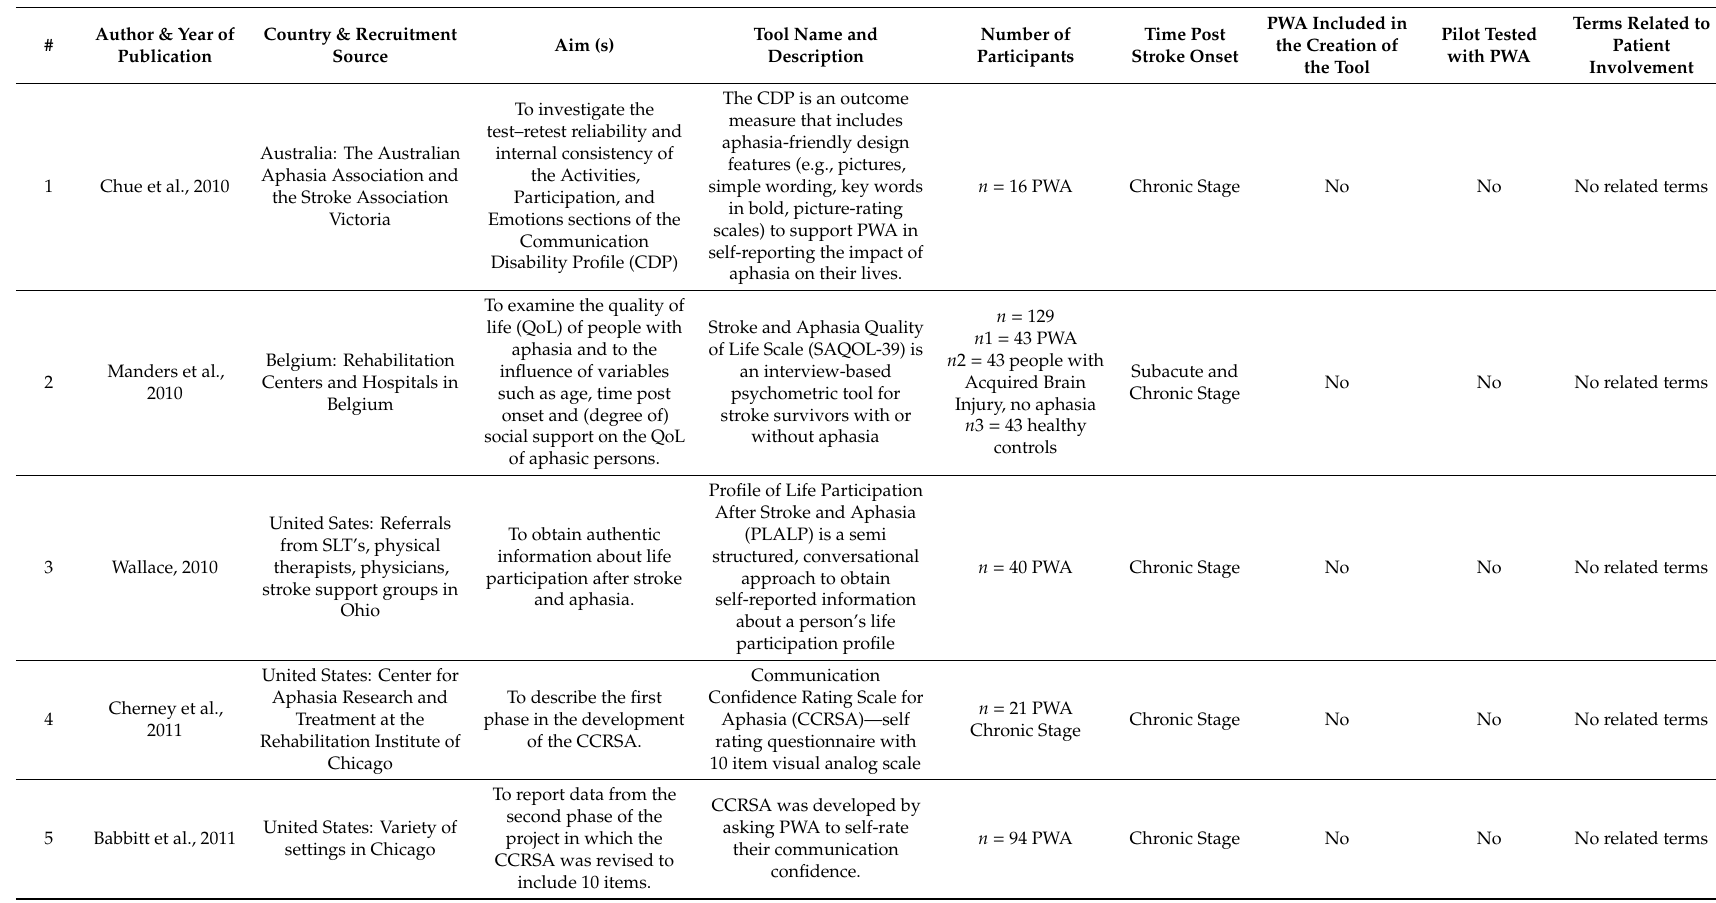
Table 1. Summary table of quality-of-life and aphasia impact-related studies for people with aphasia (PWA) in chronological